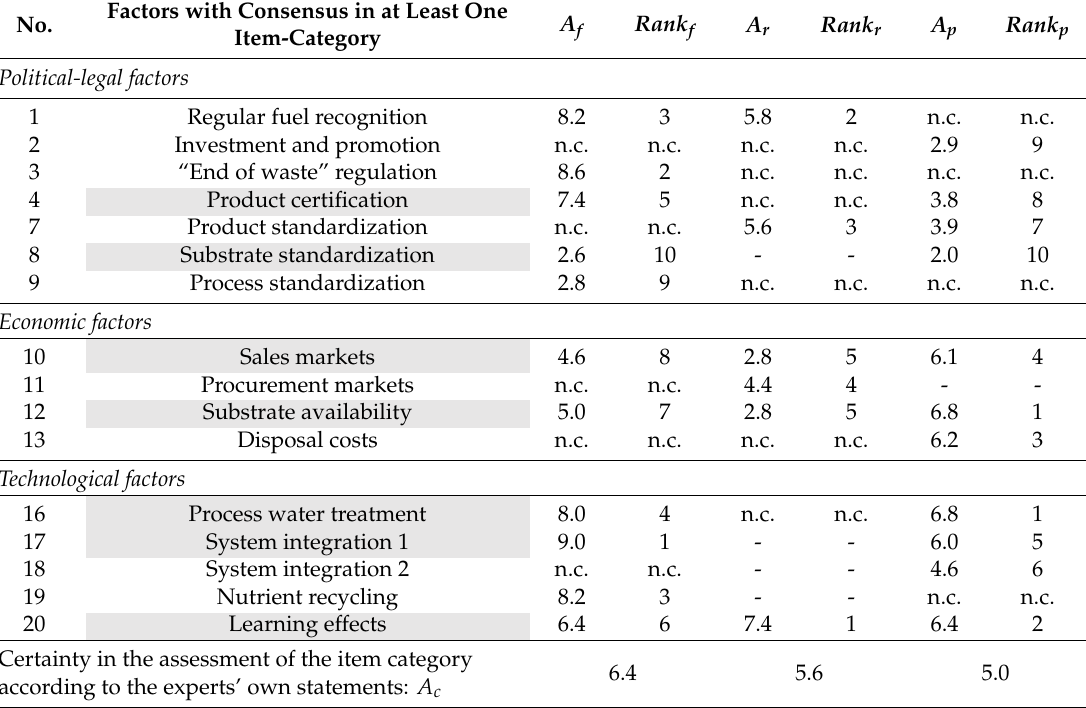
Table 3. Ranking of consensus items in terms of relevance and probabilities after